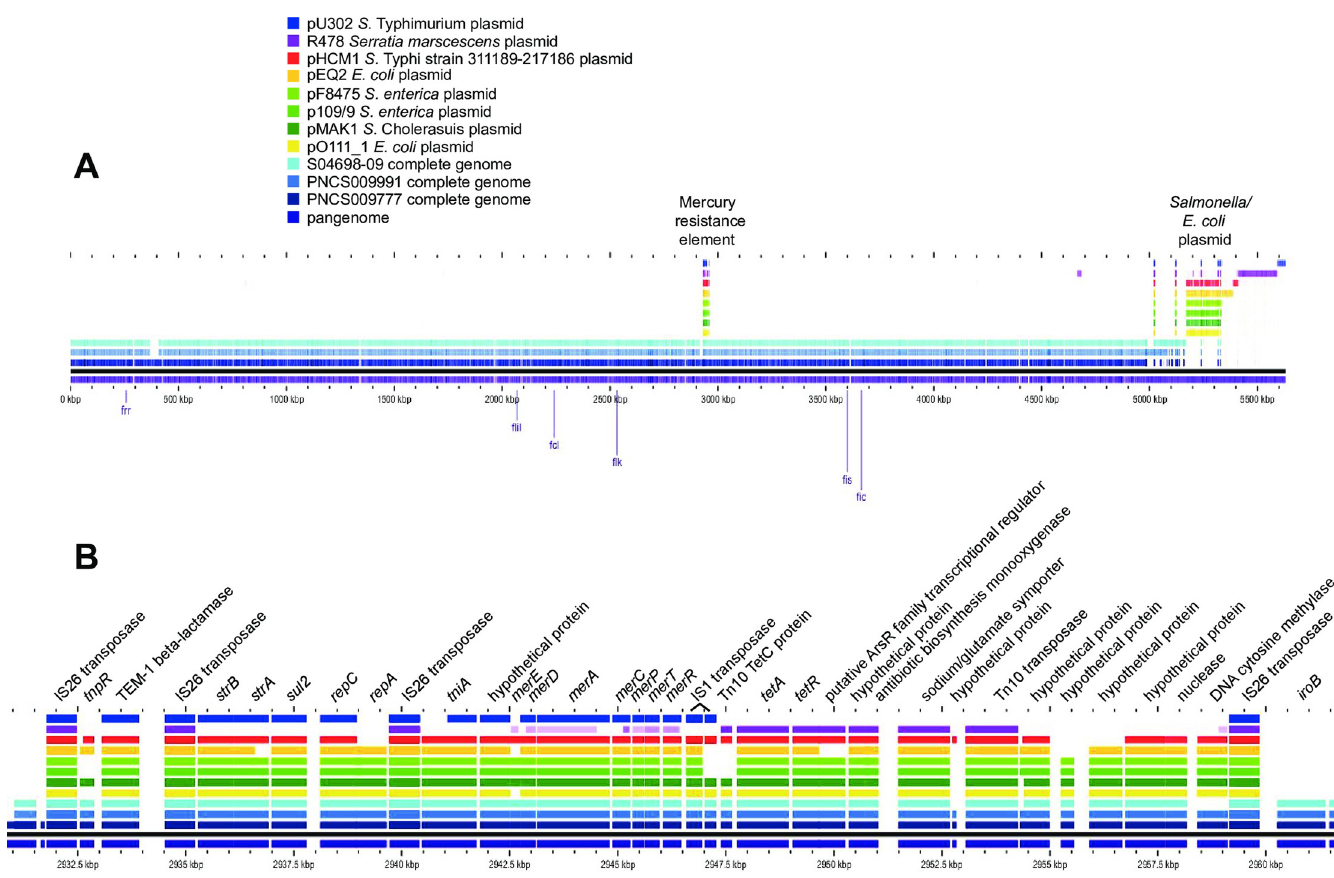
Fig 6. Gene content of plasmids with MREL genes compared with chromosomal MREL from reference genomes. Pangenome analysis was conducted using GView Server. A. Plasmids were compared with the entire genomes of reference isolates to show the location of MREL genes and identities of the plasmid backbones. B. The plasmid gene content was compared to the MRELs in reference